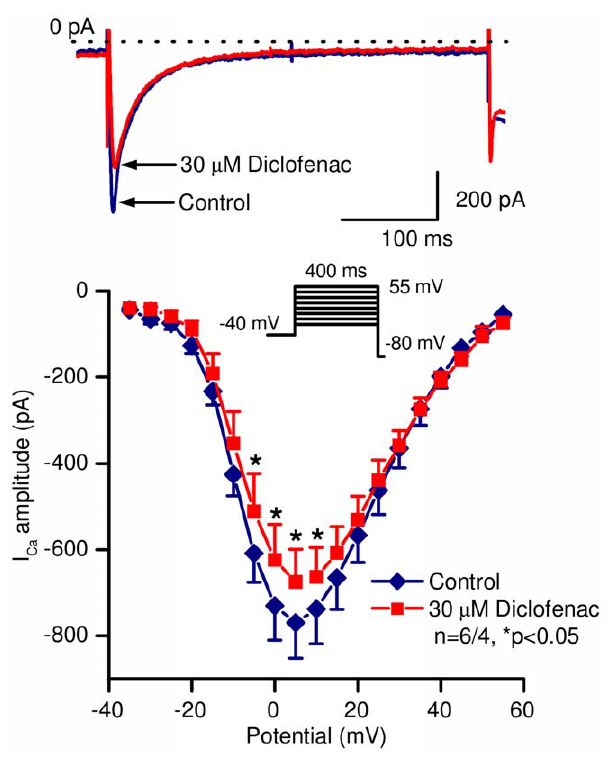
Figure 6. Effect of diclofenac on the L-type calcium current in canine ventricular myocytes. Top panel shows representative current traces, bottom panel represents current – voltage relationships under control conditions and in the presence of 30 m M diclofenac. Inset indicates the voltage protocol applied during measurements. Data are expressed as mean 6 SEM, n=number of measurements/number of animals.